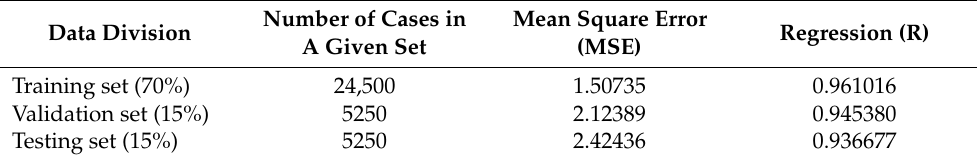
Table 1. The results of the learning process along with the division of data into